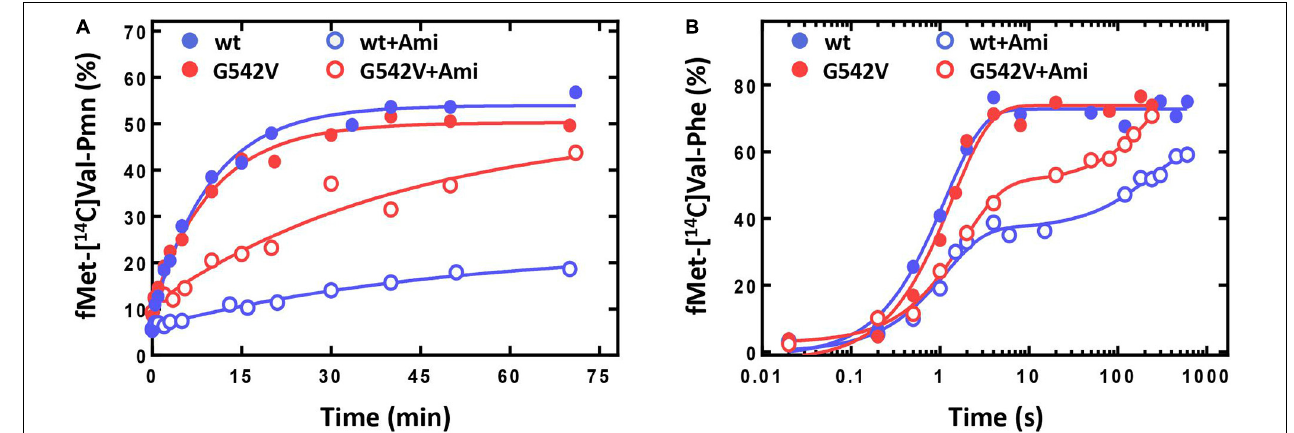
FIGURE 6 | The influence of Ami on the multiple turnover translocation catalyzed by intact or G542V EF-G. (A) The time courses of fMet-[ 14 C]Val-puromycin formation. (B) The time courses of fMet-[ 14 C]Val-Phe tripeptide formation.